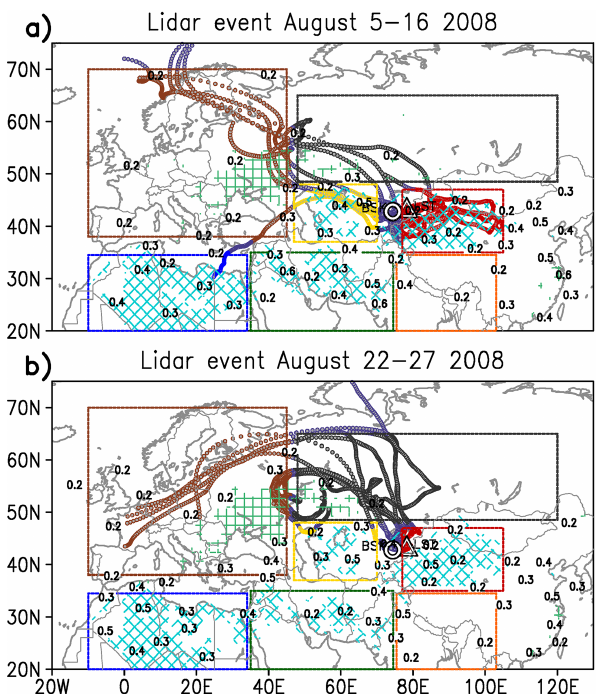
Figure 14. Ten-day air mass back trajectories for August 2008 (events 1 and 2 as denoted in Fig. 13) color-coded by source re- gions. The blue diamond and green square hatched areas denote the natural dust and biomass burning emission sources, while the numbers in black denote MODIS AOD contours averaged over the event time period and prior 10 days. The trajectories are color-coded by source regions: Africa (blue), Middle East (green), Central Asia (yellow), North Asian biomass (>50 ◦ N, black), Europe (brown), China (red), and South Asia (orange). “Lidar” denotes the LST site.